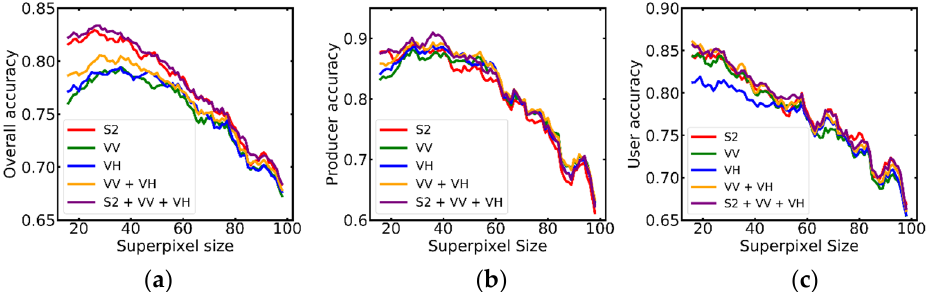
Figure 8. Overall, producer, and user accuracies of superpixel-based rice mapping. S2 represents rice mapping based on Sentinel-2 MSI images. VV represents rice mapping based on Sentinel-1 C-SAR VV images. VH represents rice mapping based on Sentinel-1 C-SAR VH images. VV + VH represents rice mapping based on Sentinel-1 C-SAR VV and VH images. S2 + VV + VH represents rice mapping based on Sentinel-2 MSI images, Sentinel-1 C-SAR VV, and VH images. ( a ) Overall accuracy; ( b ) Producer accuracy; ( c ) User accuracy .